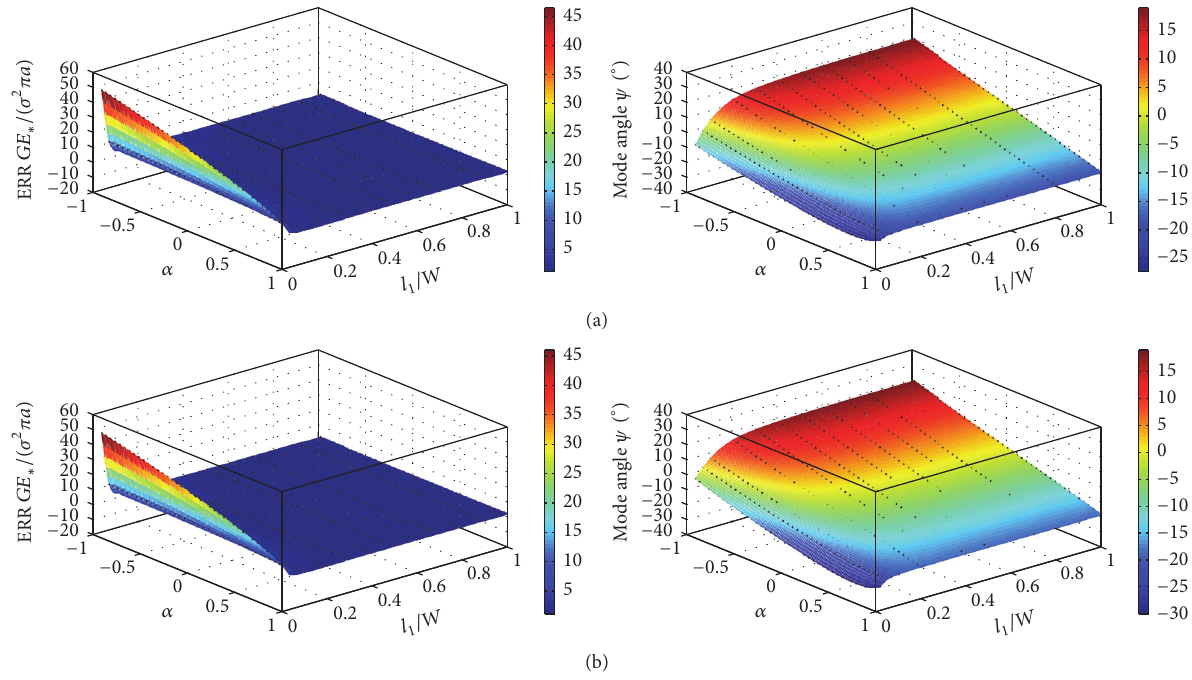
Figure 10: Normalized ERR 𝐺𝐸 ∗ /(𝜎 2 𝜋𝑎) and mode angle 𝜓 of an asymmetrically bonded strip for (a) 𝛽 = 0.25𝛼 and (b) 𝛽 = 0.325𝛼 . 01020304050